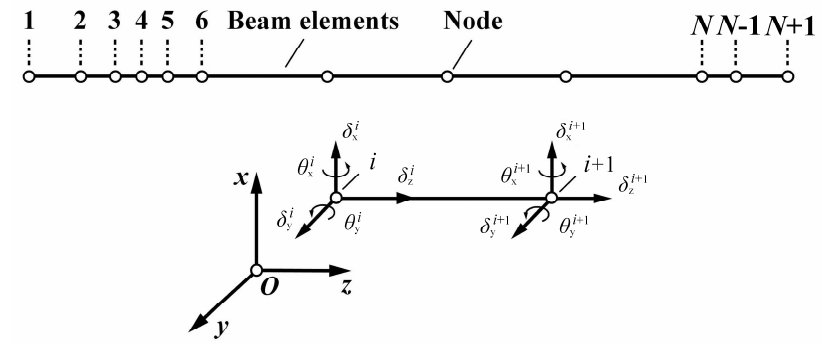
Figure 5. Finite element model for the shaft.